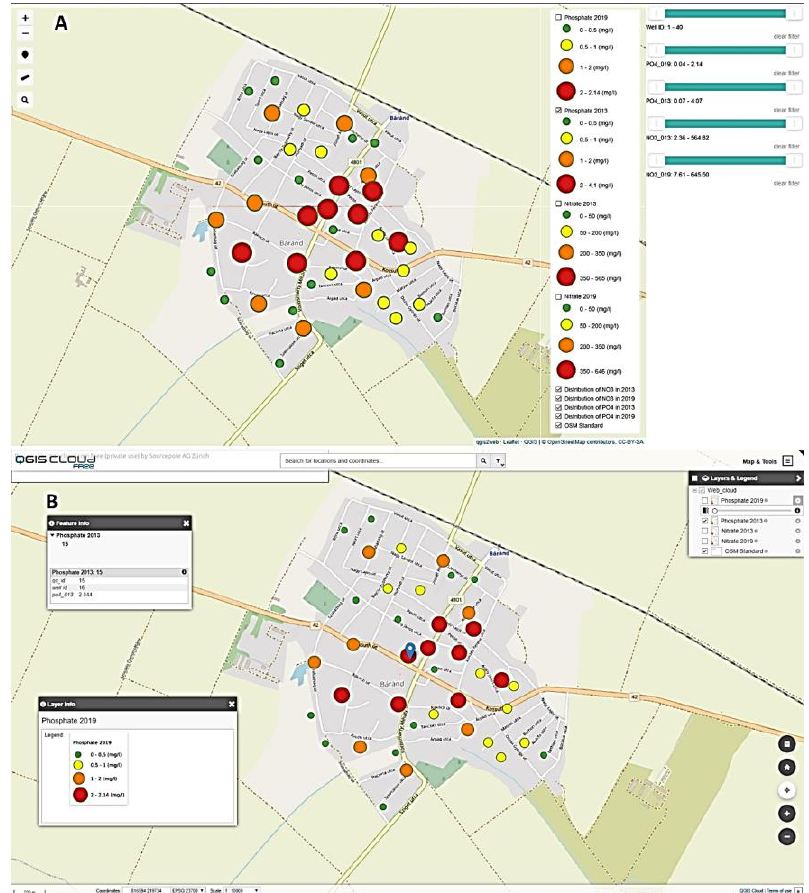
Figure 4. Interactive web maps from the study area ( A ) Results of geovisualization using QGIS Cloud, ( B ) Results of geovisualization using QGIS qgis2web.